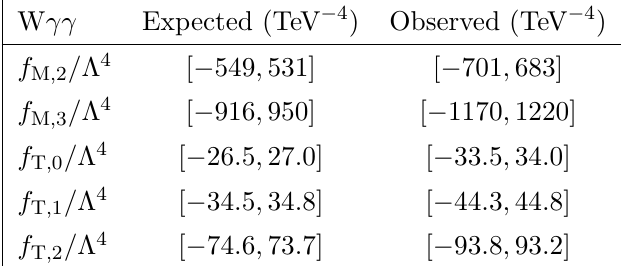
are de(cid:12)ned for W and Z boson decays to a single lepton family. The measured (cid:12)ducial cross sections for these (cid:12)nal states are, respectively, 4 : 9 (cid:6) 2 : 1 fb and 12 : 7 (cid:6) 2 : 3 fb, consistent